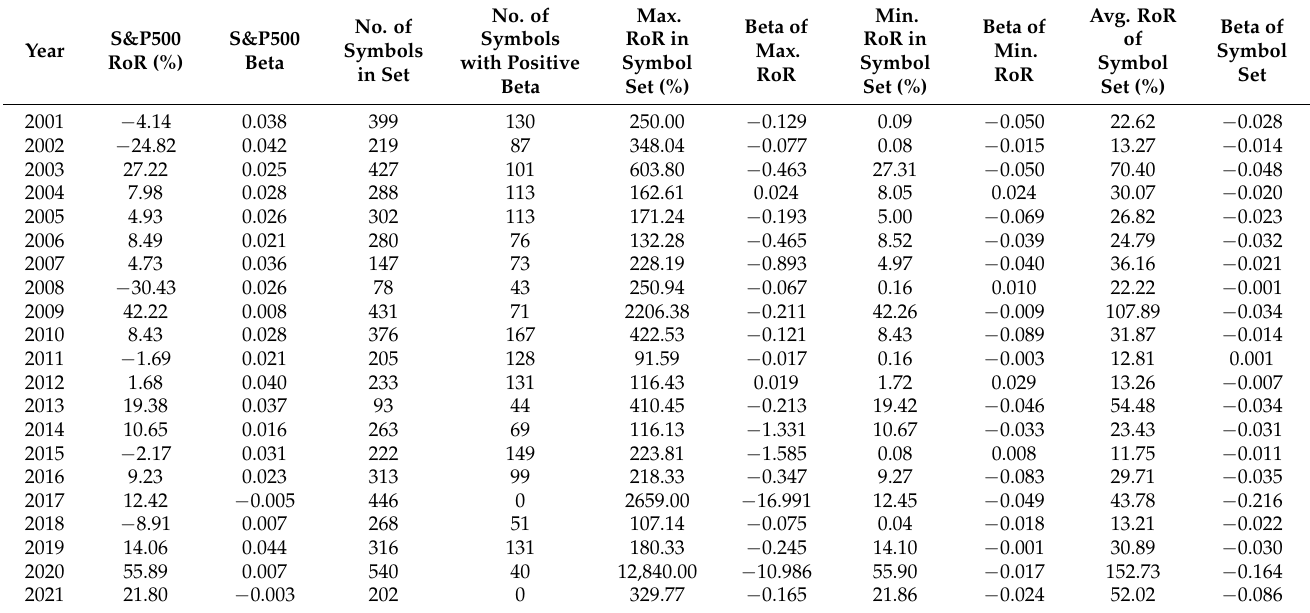
Table 1. Sets of NYSE stocks, selected annually, based on the rate of return (RoR) of the S&P500 index and its beta relative to the CSIE of the market as a